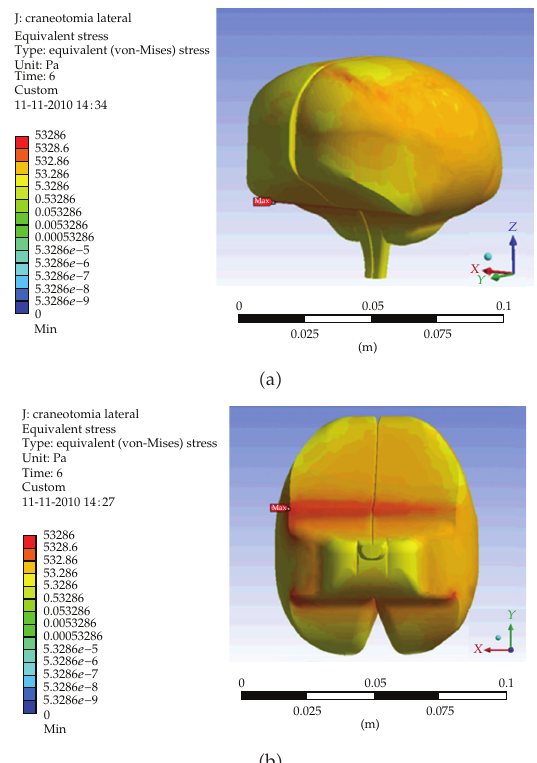
Figure 8: E ff ective stress for parietal craniotomy, hyperelastic second-order Ogden model.